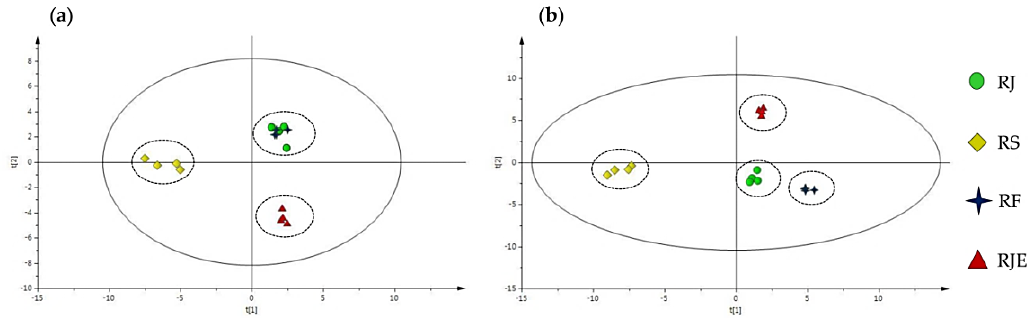
Figure 8. ( a ) Score plots by OPLS-DA with anatomical characteristics only; ( b ) OPLS-DA with anatomical characteristics combined with the HPLC profile data for the four Reynoutria plants.